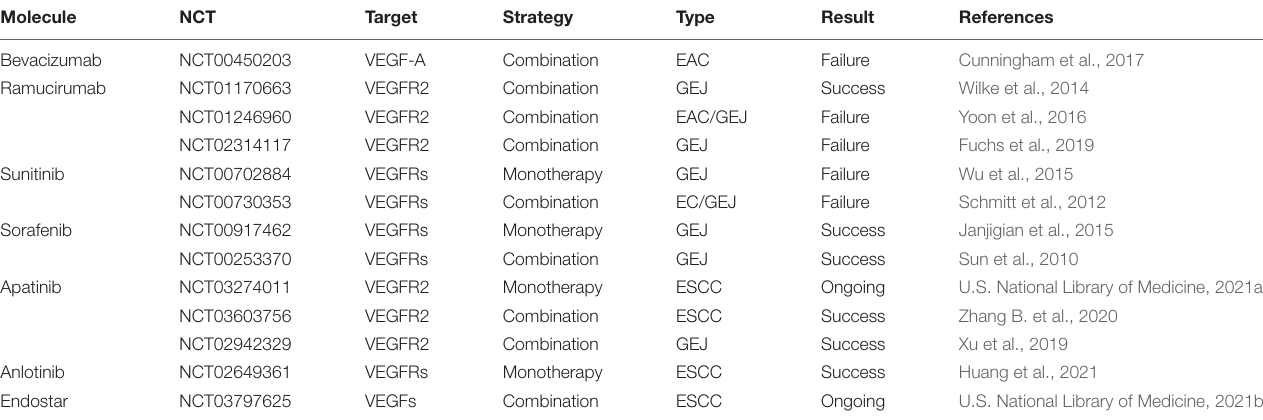
TABLE 1 | Vascular endothelial growth factor inhibitors applied to esophageal